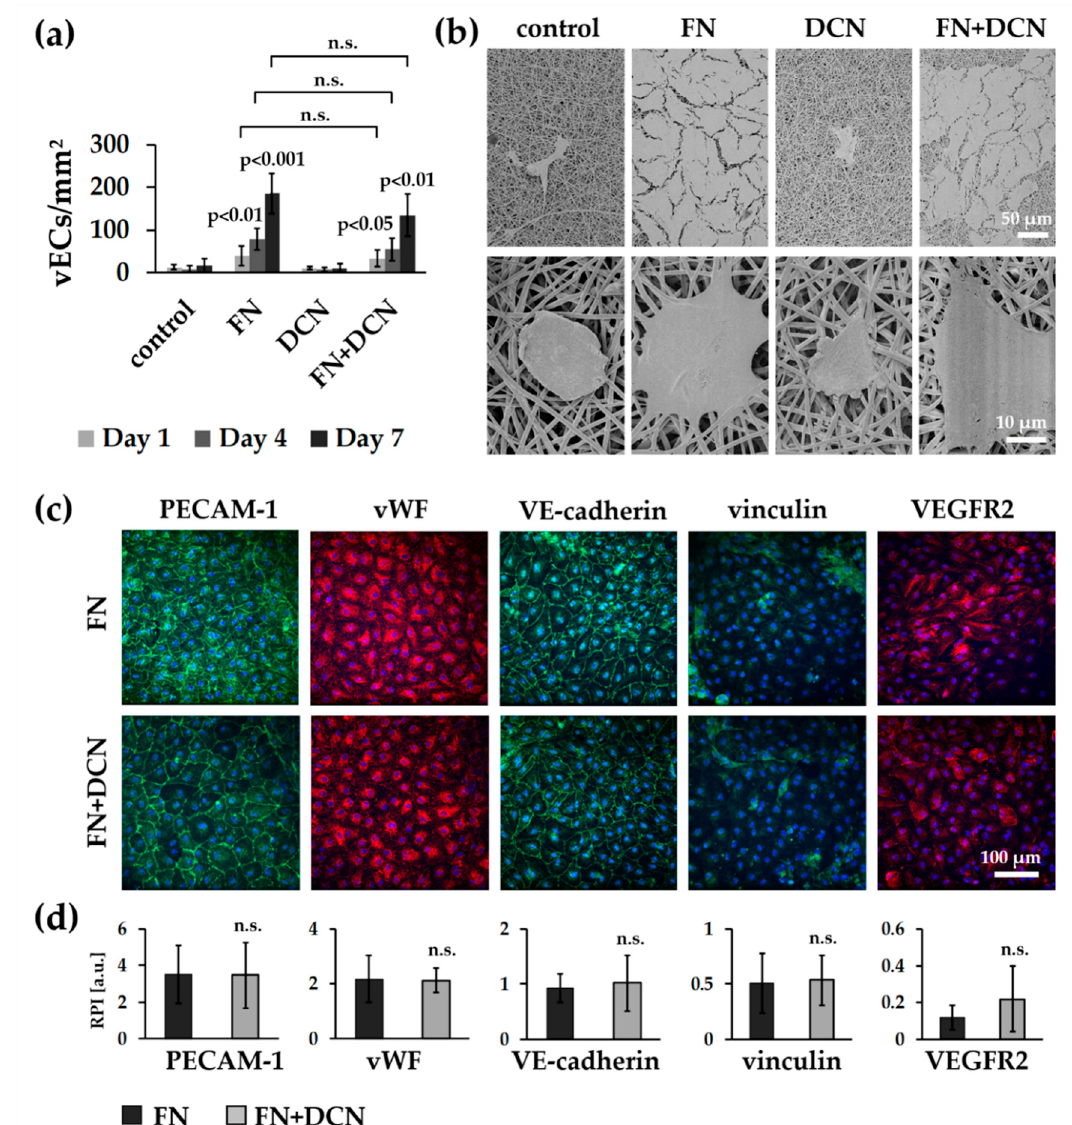
Figure 7. Static cell culture experiments of vECs on FN- and DCN-coated scaffolds: ( a ) Attachment and proliferation of vECs after 1, 4, and 7 days. vECs on FN and FN + DCN coating show a significantly higher proliferation rate compared with cells gown on DCN coating or control scaffolds. Two-tailed t -test, compared with control samples, n = 3, n.s.= not significant. ( b ) SEM images and ( c ) IF staining of vECs 7 days after seeding on ECM-coated scaffolds. Cells on FN and FN + DCN coating show a spread morphology in contrast with cells on DCN coating and control samples. ( d ) Semiquantitative fluorescence intensity analysis (relative pixel intensity (a.u.)) of cells on FN and FN + DCN coating shows no significant difference for PECAM-1, vWF, vinculin, or VE-cadherin expression. Two-tailed t -test, n = 5, n.s.= not significant.